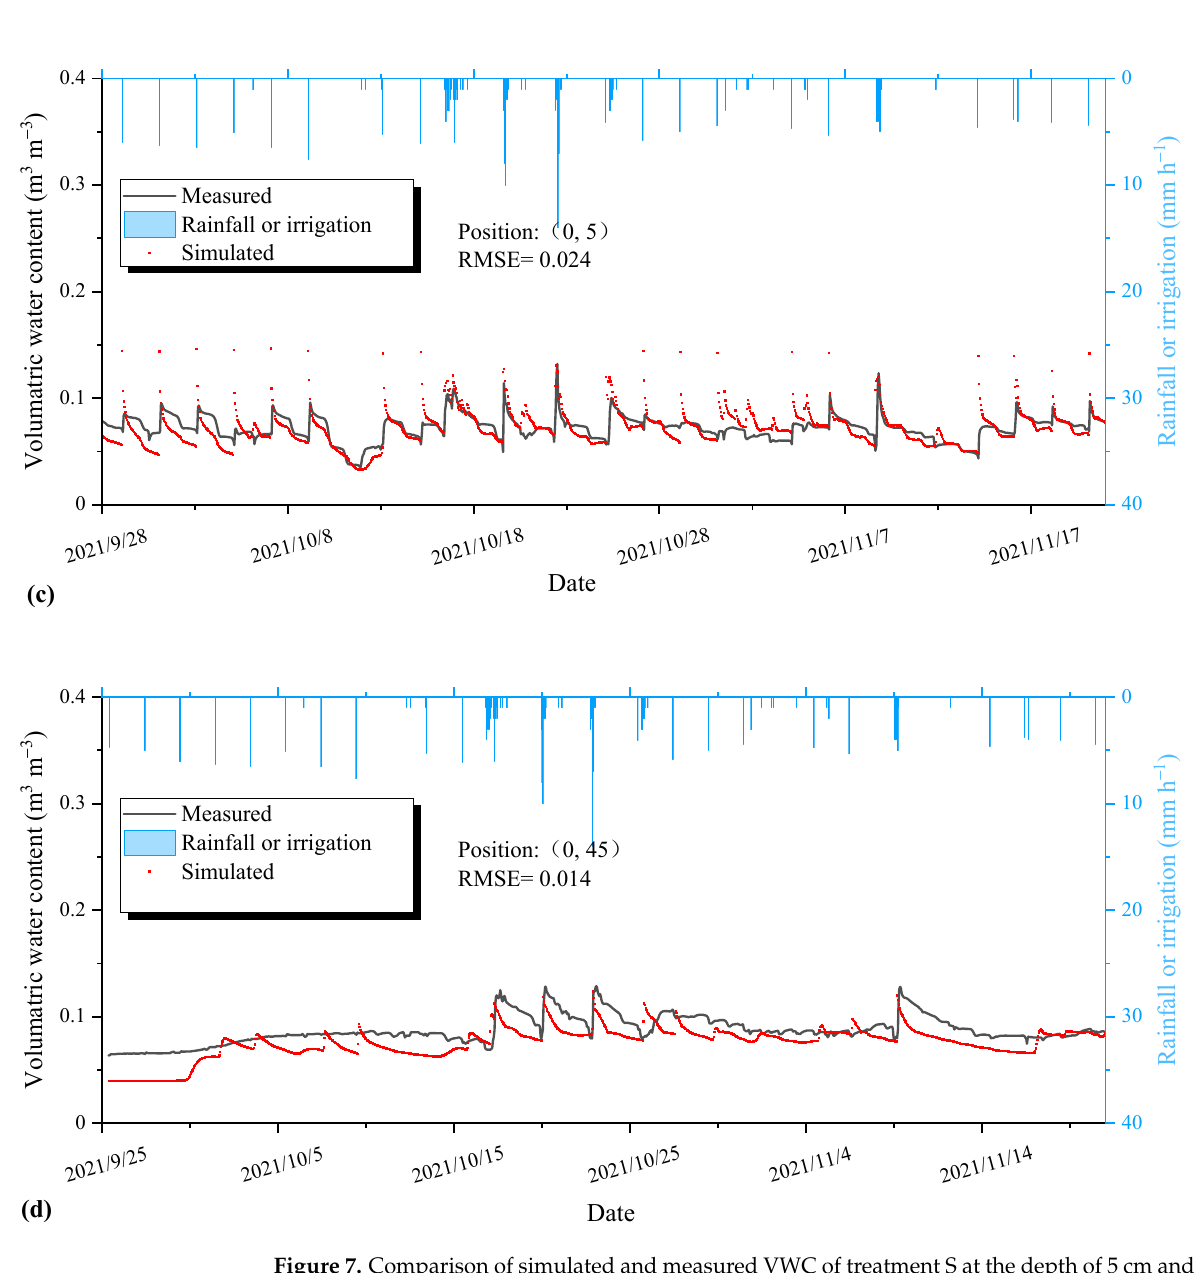
Figure 7. Comparison of simulated and measured VWC of treatment S at the depth of 5 cm and 45 cm below the drip tube in two seasons. ( a , b ) are the VWC at the site of (0, 5) and (0, 45) in the first season, respectively; ( c , d ) are the VWC at the site of (0, 5) and (0, 45) in the second season, respectively. RMSE is root mean square error.